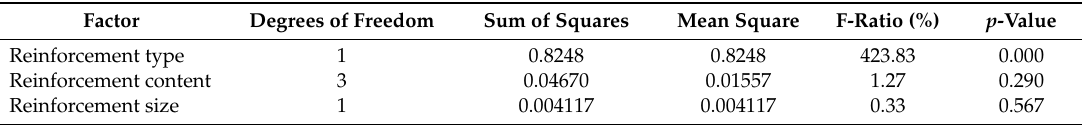
Table 5. One-way ANOVA of differential